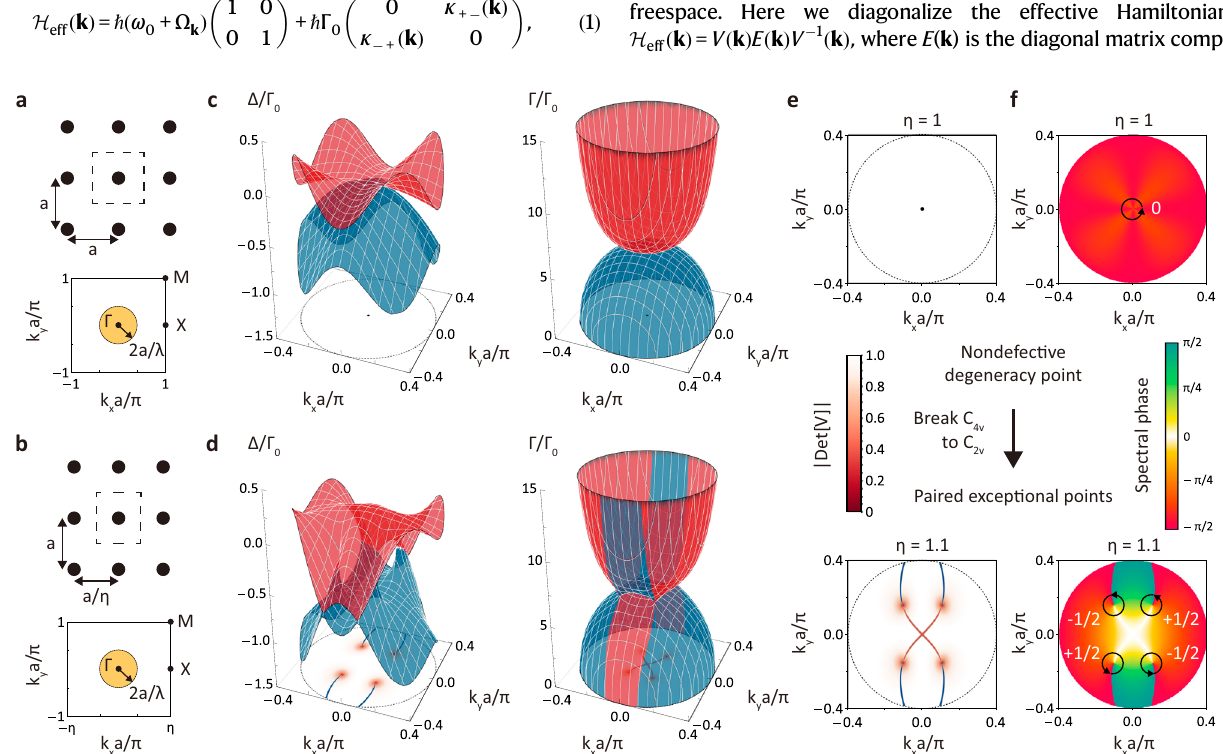
Fig. 1 | Paired exceptional points split from a nondefective degeneracy point. Schematics of square ( a ) and rectangular ( b ) atomic lattices and their irreducible Brillouinzonesinthesubwavelengthregime.Theyellowcircularregionrepresents the light cone, wherein the system is non-Hermitian. Collective frequency shift Δ k andoveralldecayrate Γ k ofin fi nitesquare( c )andrectangular( d )latticeswithinthe light cone (black dashed circle). Two energy bands E 1,2 ð k Þ = _ ð ω 0 + Δ k Þ(cid:2) i colored in red and blue, respectively. e A non-Hermitian degeneracy point can be identi fi ed as NDP or EP by calculating det ½ V ð k Þ(cid:3) . The η =1 case shows that the non-